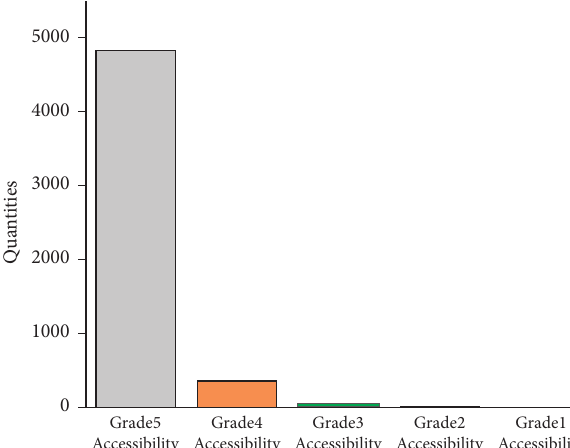
Figure 9: Accessibility performance during morning peak